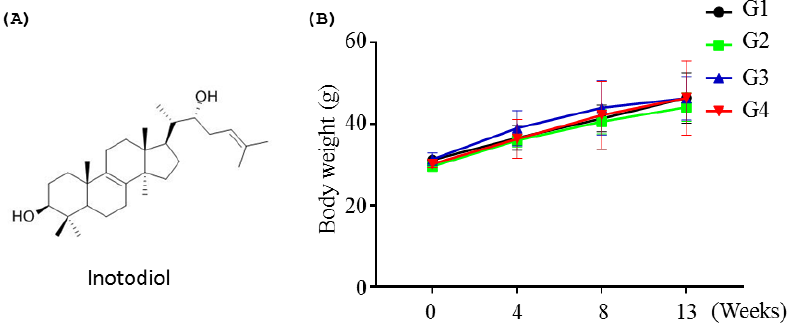
Figure 1. Body weight changes on repeated dose toxicity study. In the experiment, five male ICR mice were administered with or without INO95 and INO20 once a day for 13 weeks. ( A ) The structure of INO95. ( B ) Body weight changes were evaluated for 13-week treatment. The data shown represent mean ± S.D. ( n = 5).